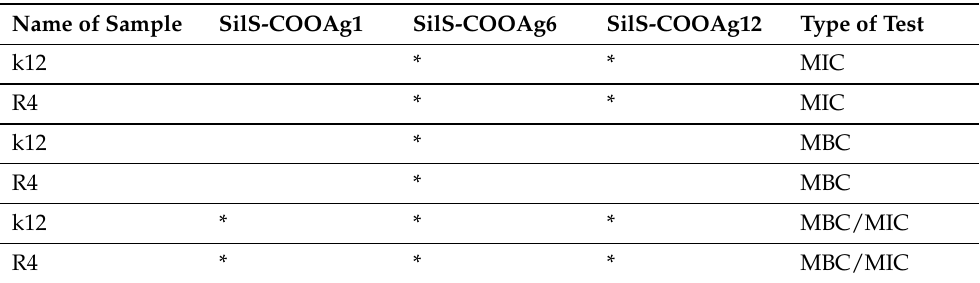
Table 1. Statistical analysis of all analyzed nanocomposites by MIC, MBC, and MBC/MIC. The sign * means statistical significance below